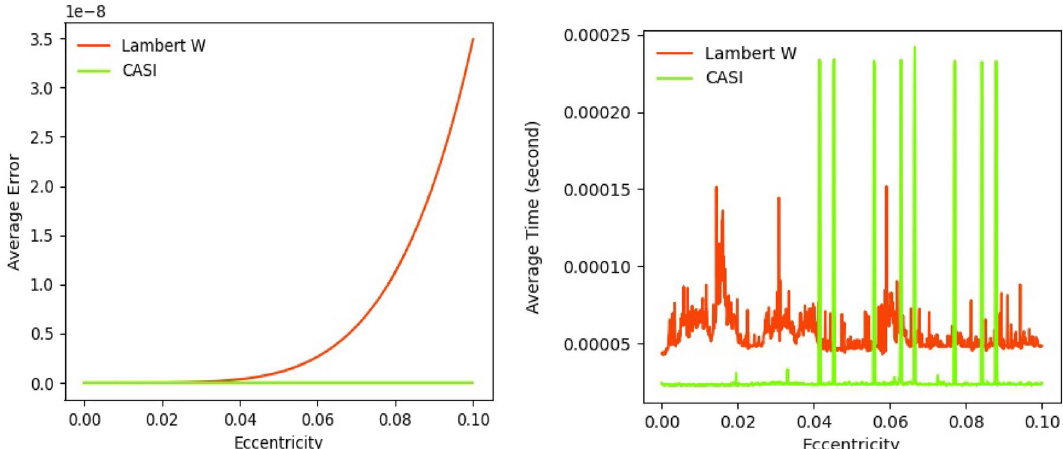
Figure 12. Numerical comparisons among the SICAA method and the Lambert W method to solve the Kepler’s equation. Errors (left) and CPU times (right, units: second) are averaged with respect to M ∈ [0, π ] over the domain e ∈ [0, 0.1]